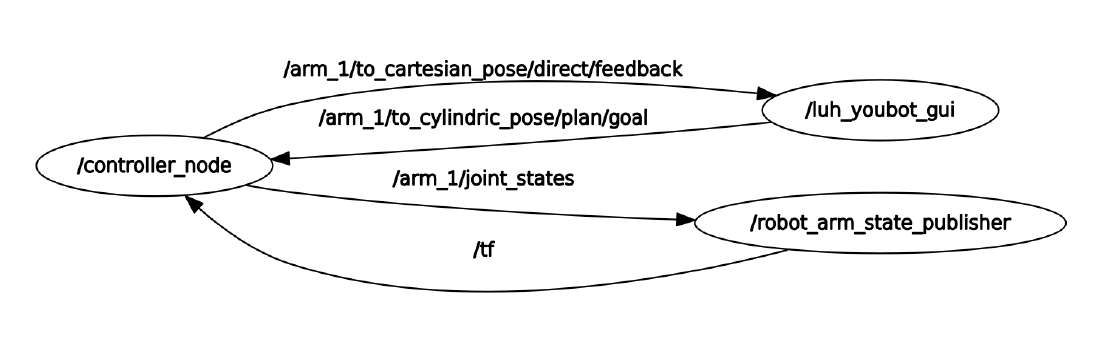
Figure 10. Rqt ROS